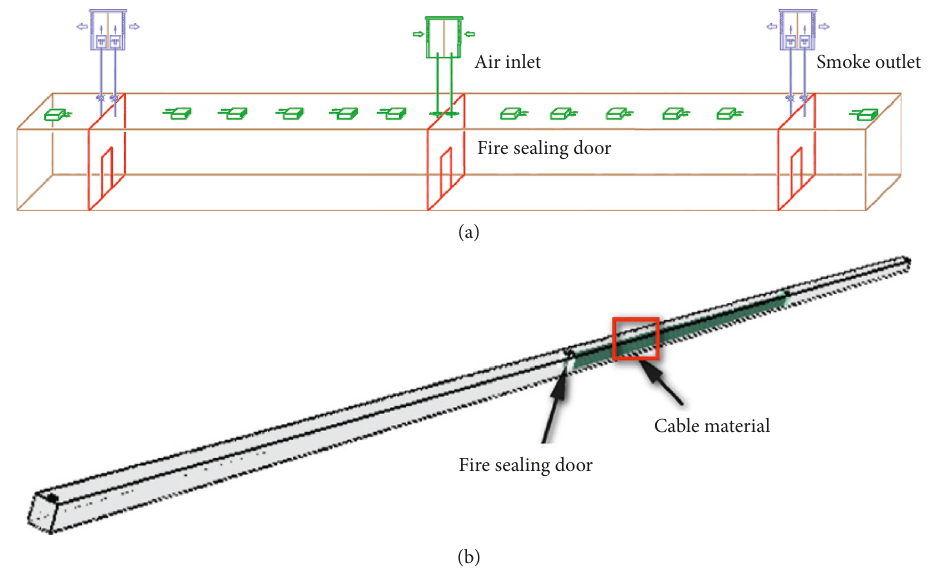
Figure 8: Utility tunnel ventilation mode. (a) Practical tunnel ventilation. (b) Simulation model in FDS.